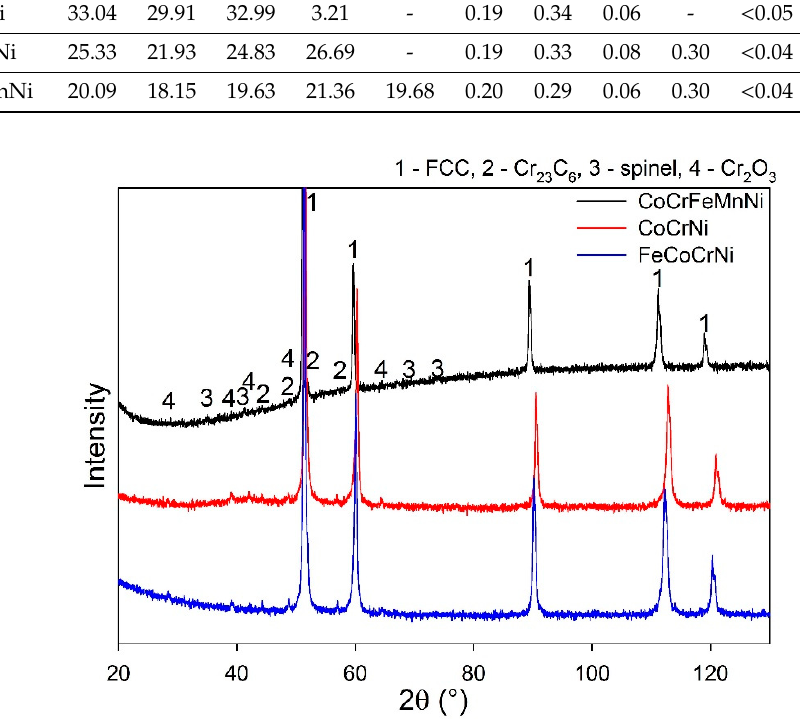
Table 1. Elemental composition of the sintered alloys in wt. %. Carbon and oxygen are not included in the analysis due to the low sensitivity of the X-ray fluorescence (XRF) detector. (wt. %)